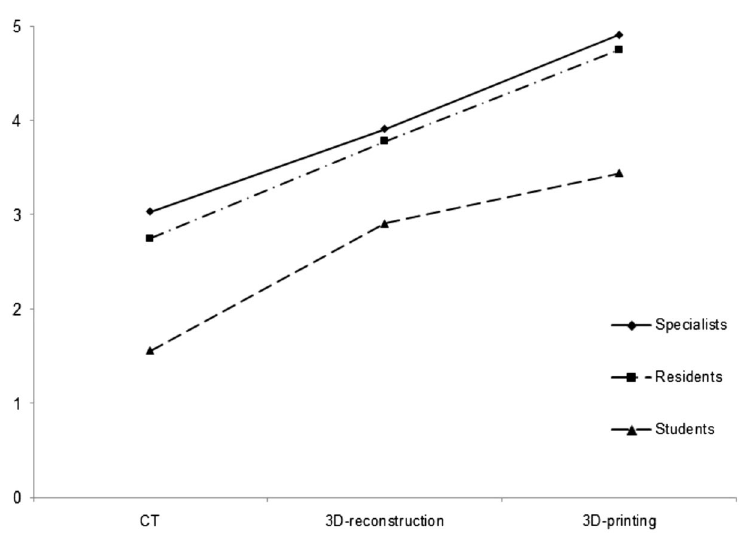
Figure 2. The understanding of lesions using computed tomography, 3D reconstruction and 3D printed models by each group.